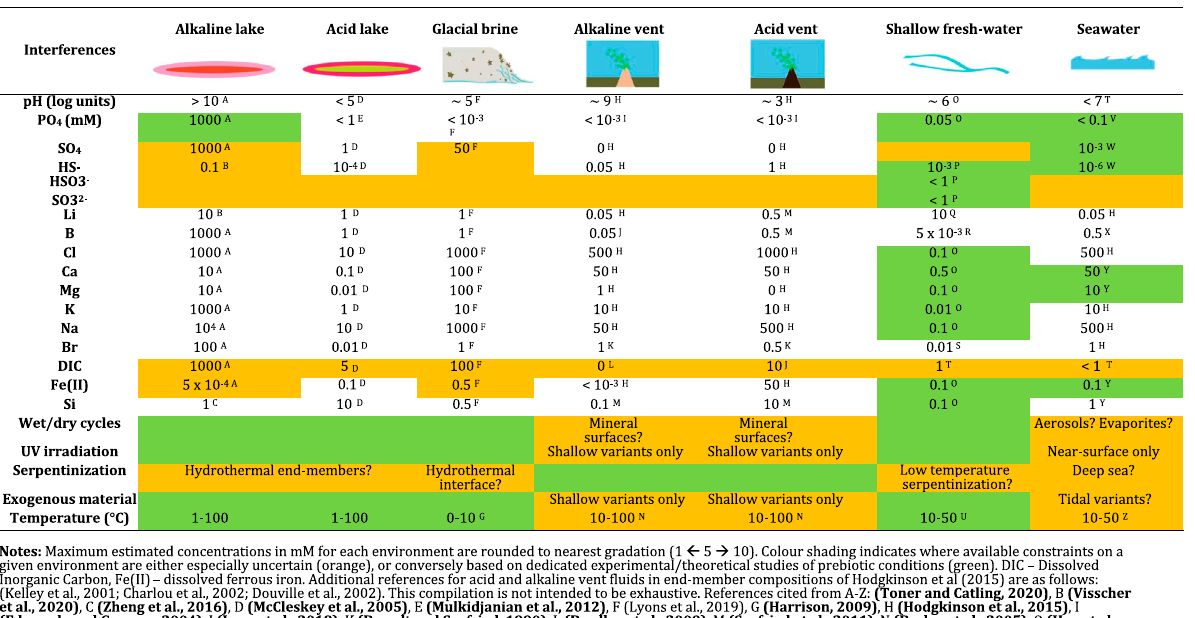
TABLE 1 A geochemical roadmap of prebiotic